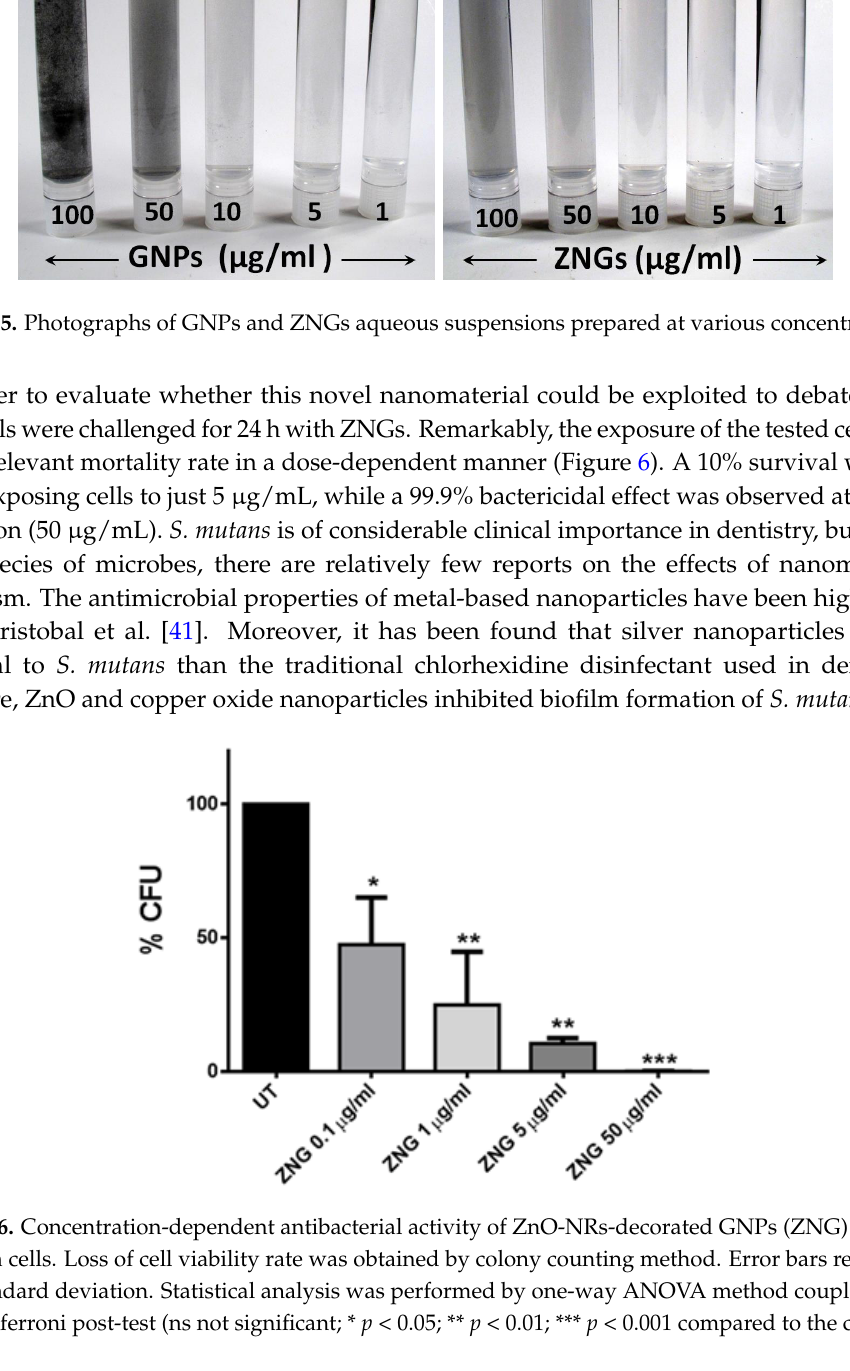
Figure 6. Concentration-dependent antibacterial activity of ZnO-NRs-decorated GNPs (ZNG) against bacteria cells. Loss of cell viability rate was obtained by colony counting method. Error bars